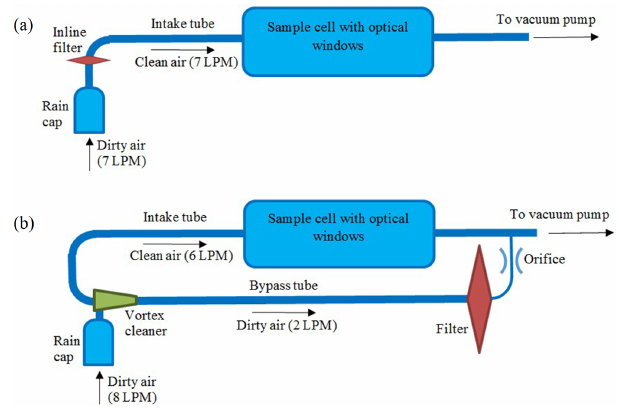
Figure 3. Schematics of EC155 sampling systems with (a) an orig- inal inline filter and (b) vortex intake.